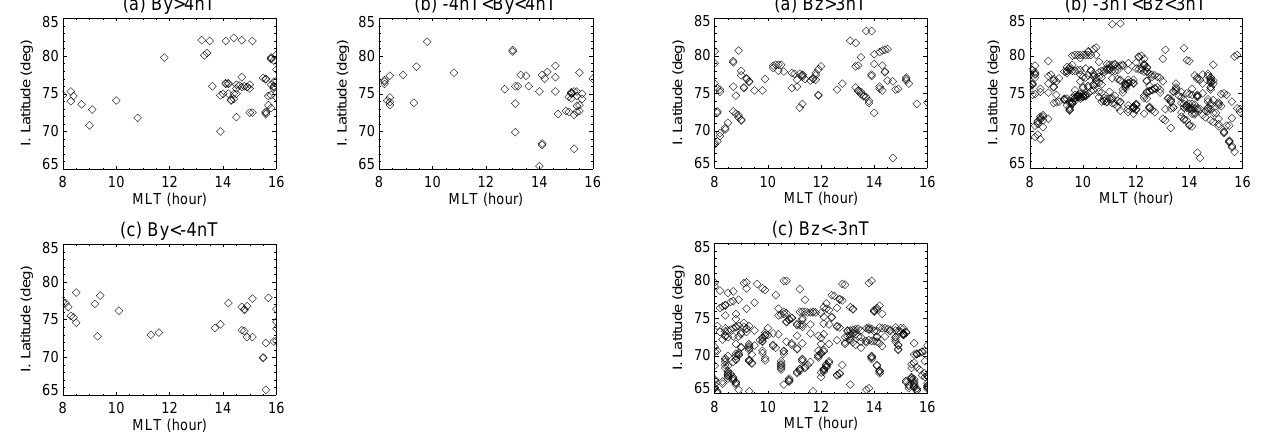
Fig. 2. Location of energetic ( > 100eV) ion beam event in MLT- I.Lat coordinate when IMF B y is (a) strongly positive, (b) nearly zero, and (c) strongly negative.